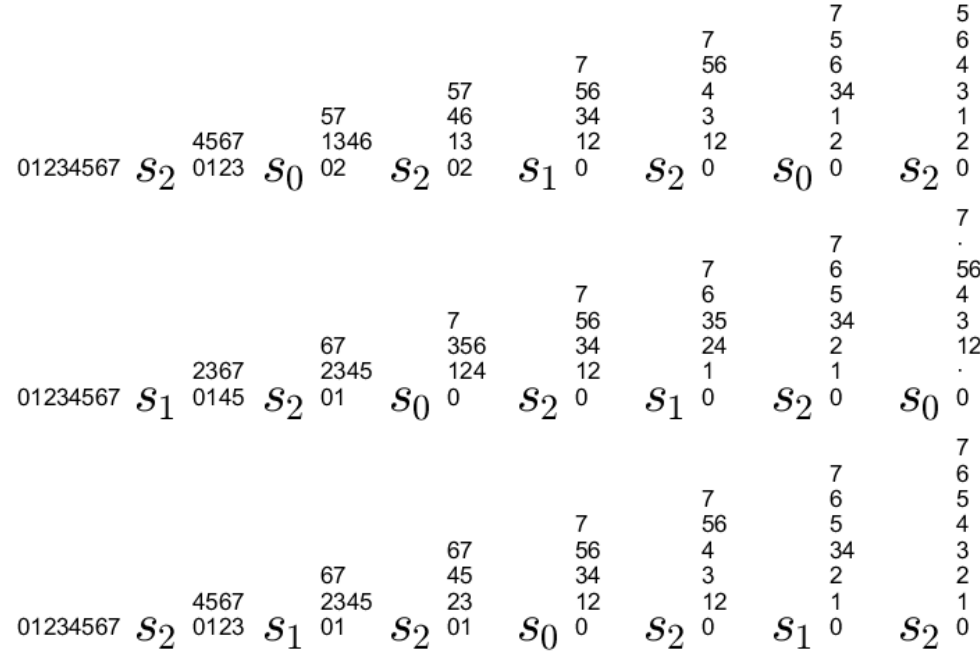
Figure 6. Depiction of how slopes ascend for different bits boundaries, for size N =